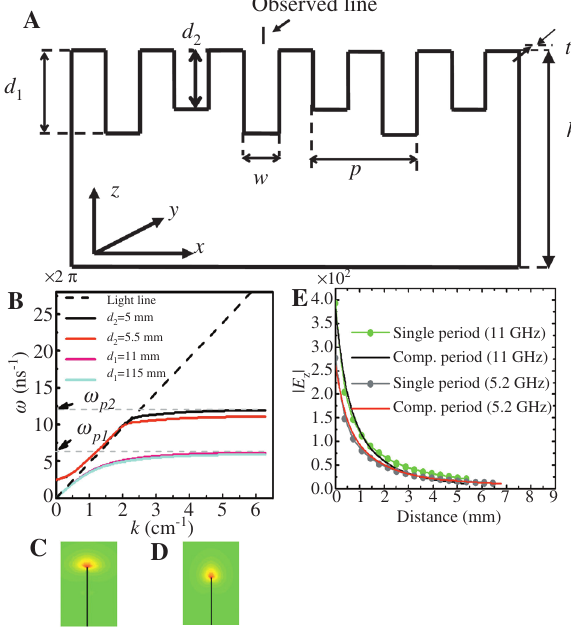
Figure 5: (A) The sketch of the dual-periodic planar metamaterial. (B) Dispersion curves of the dual-periodic grooves with depth d d , where w = 1 mm, p = 5 m, and h = 40 mm. (C, D) The mode patterns 2 of E field of the dual-periodic grooves. (E) The E z along the observed line [see (A)] above the composite periodic grooves and single periodic grating at 5.2 GHz and 11 GHz, respec- tively. Reproduced from [42] with permission.